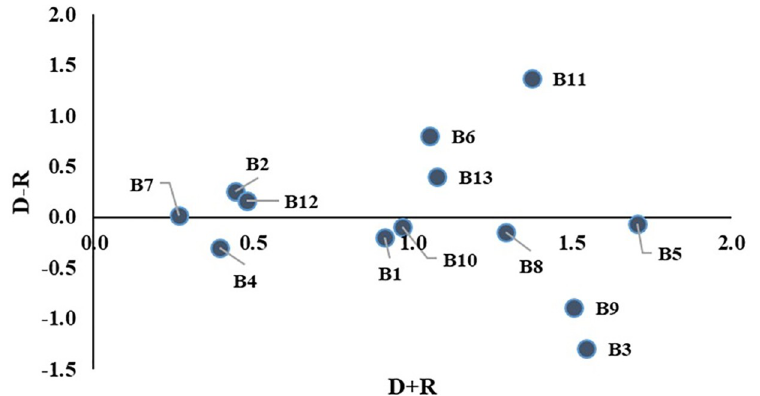
Fig 9. The relationships among the barriers for sensitivity analysis Case 3.